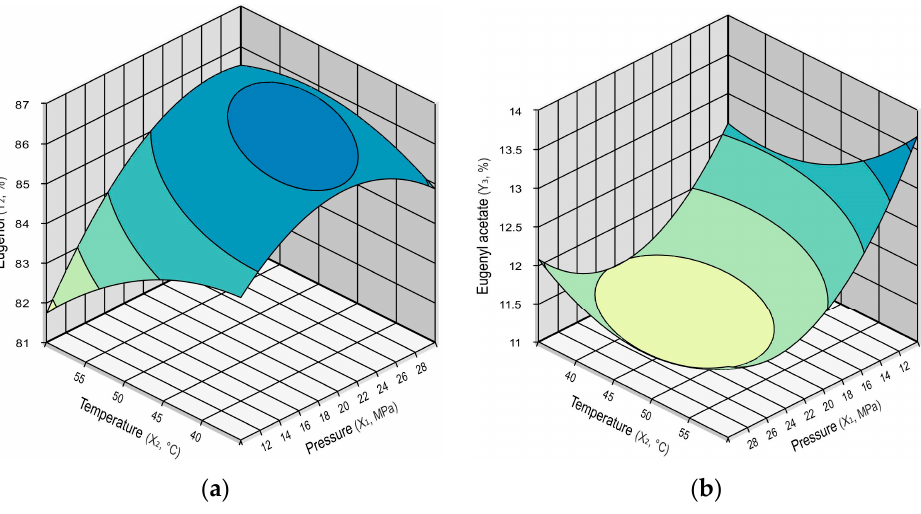
Figure 7. The response surface for ( a ) eugenol; ( b ) eugenyl acetate.